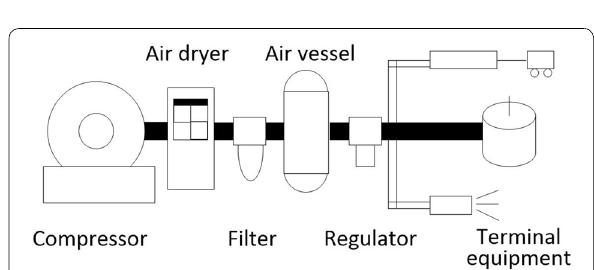
Figure 5 A typical compressed air system